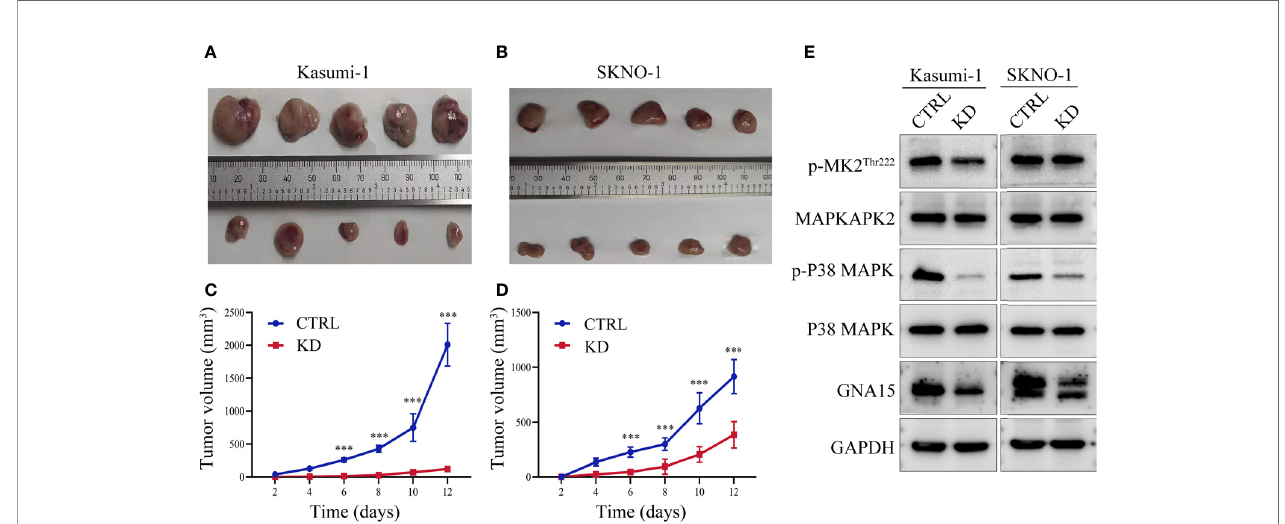
FIGURE 6 | GNA15 knockdown reduces the proliferation ability of AML cells in nude mice by inhibiting the P38 MAPK signaling pathway. (A – D) GNA15 -KD inhibits tumor growth in Kasumi-1 and SKNO-1 cells. (E) The expression of P38 MAPK signaling pathway proteins in tumor tissues by Western blot. CTRL, control; KD, knockdown; *** P < 0.001 compared with CTRL cells. Error bars indicate the standard